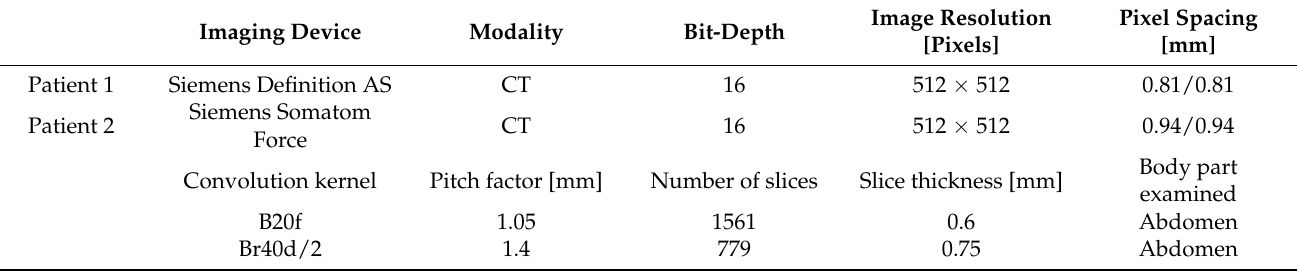
Table 2. Technical and metadata information of computed tomography image datasets per patient.